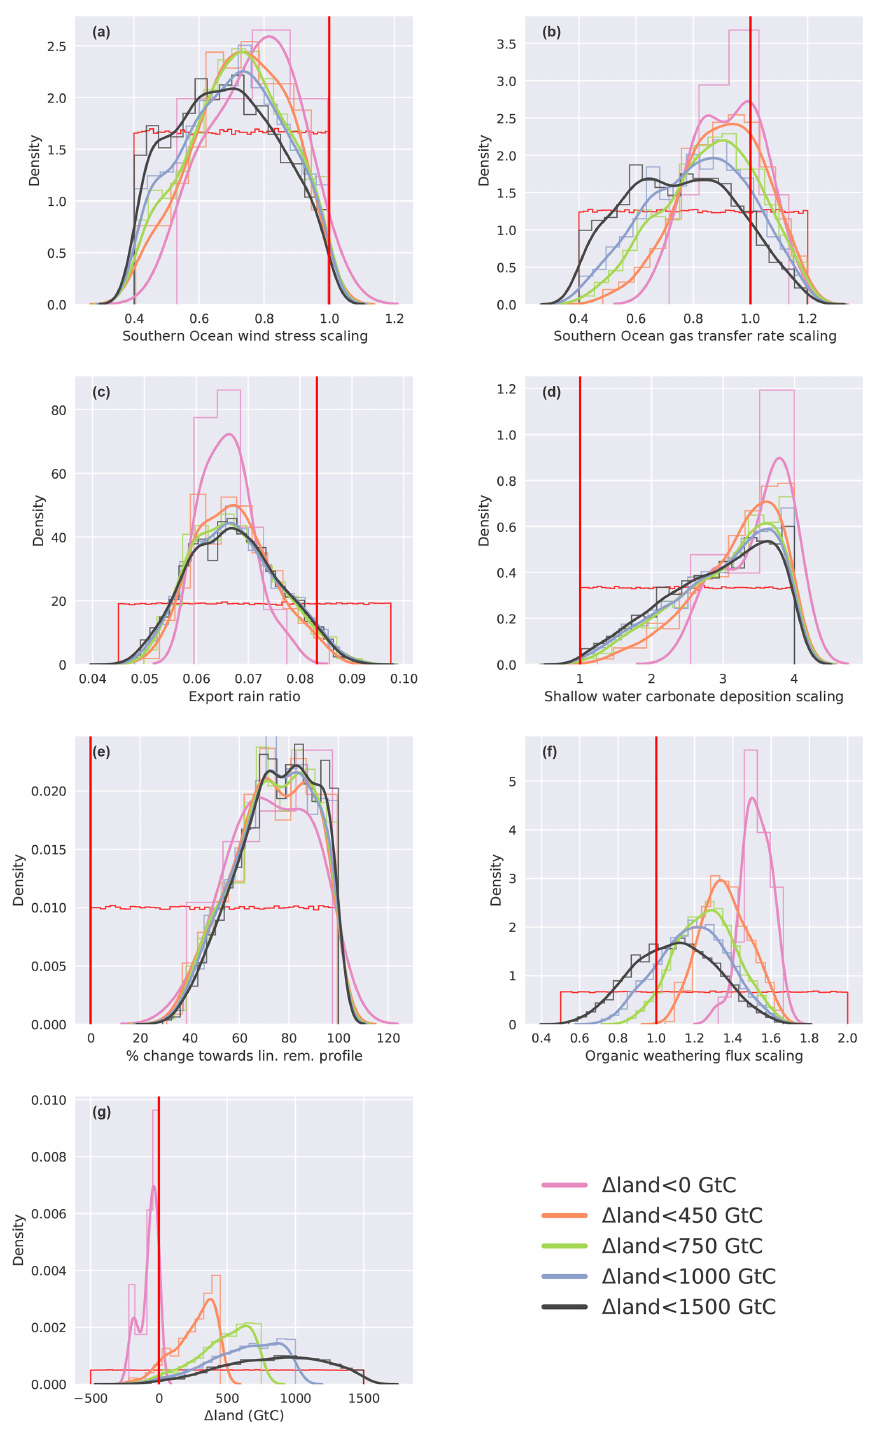
Figure C2. Histograms (colored thin line, normalized) and ker- nel density estimates (colored thick line) of applied changes in the seven mechanisms (a–g) for all emulator results that fulfill the four observational constraints. The colors of the lines correspond to sub- samples of these results according maximum changes in (cid:49) land of 1500, 1000, 750, 450, and 0GtC. The thin red line gives the histogram of the prior distribution and the vertical thick red line the standard parameter value. For details on the mechanisms see Sect.